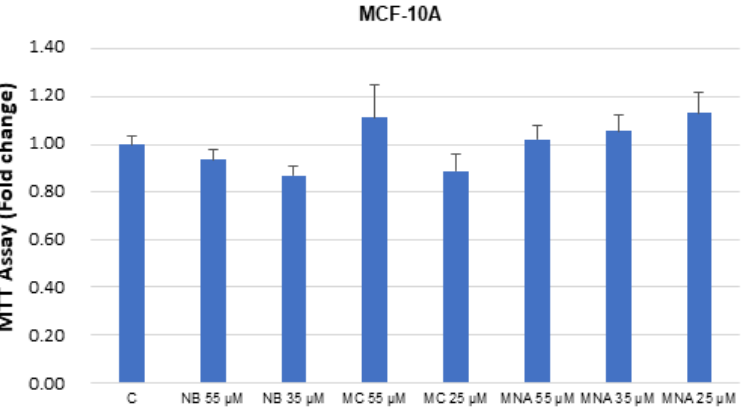
Figure 8. MTT growth assays in MCF-10A cells untreated (control, C) or treated with doses of NB, MC, and MNA at IC 50 for 24 h. Cell proliferation is expressed as fold change ± S.D. relative to vehicle-treated cells and is representative of three different experiments, each performed in triplicate. Statistical comparison was drawn between groups using a two-sample two-tailed t-test.